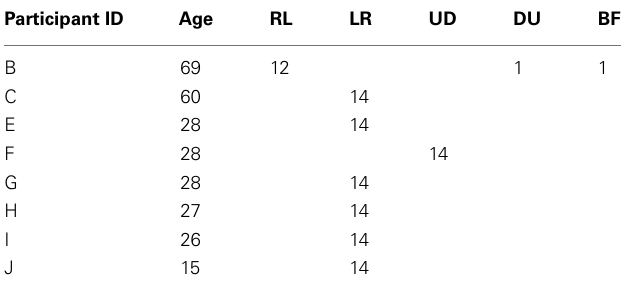
Table 3 | Frequency of arrangement direction in the time-points task.